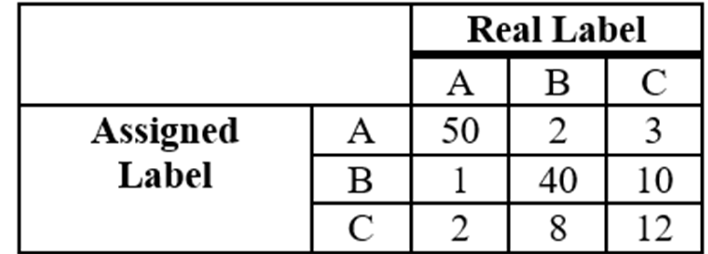
Figure 1. Example of a Confusion matrix for three